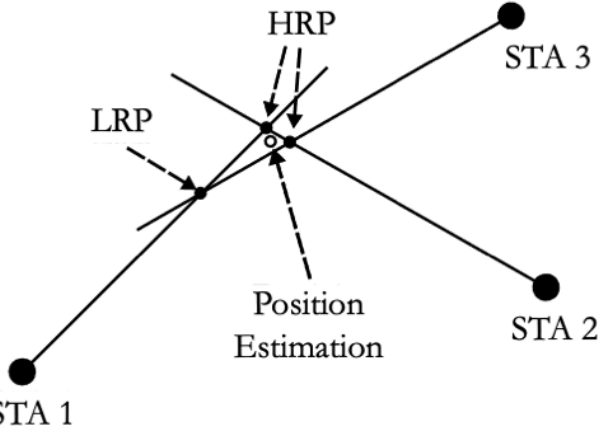
Figure 4. Representation of multiple intersections from three different VOR stations.